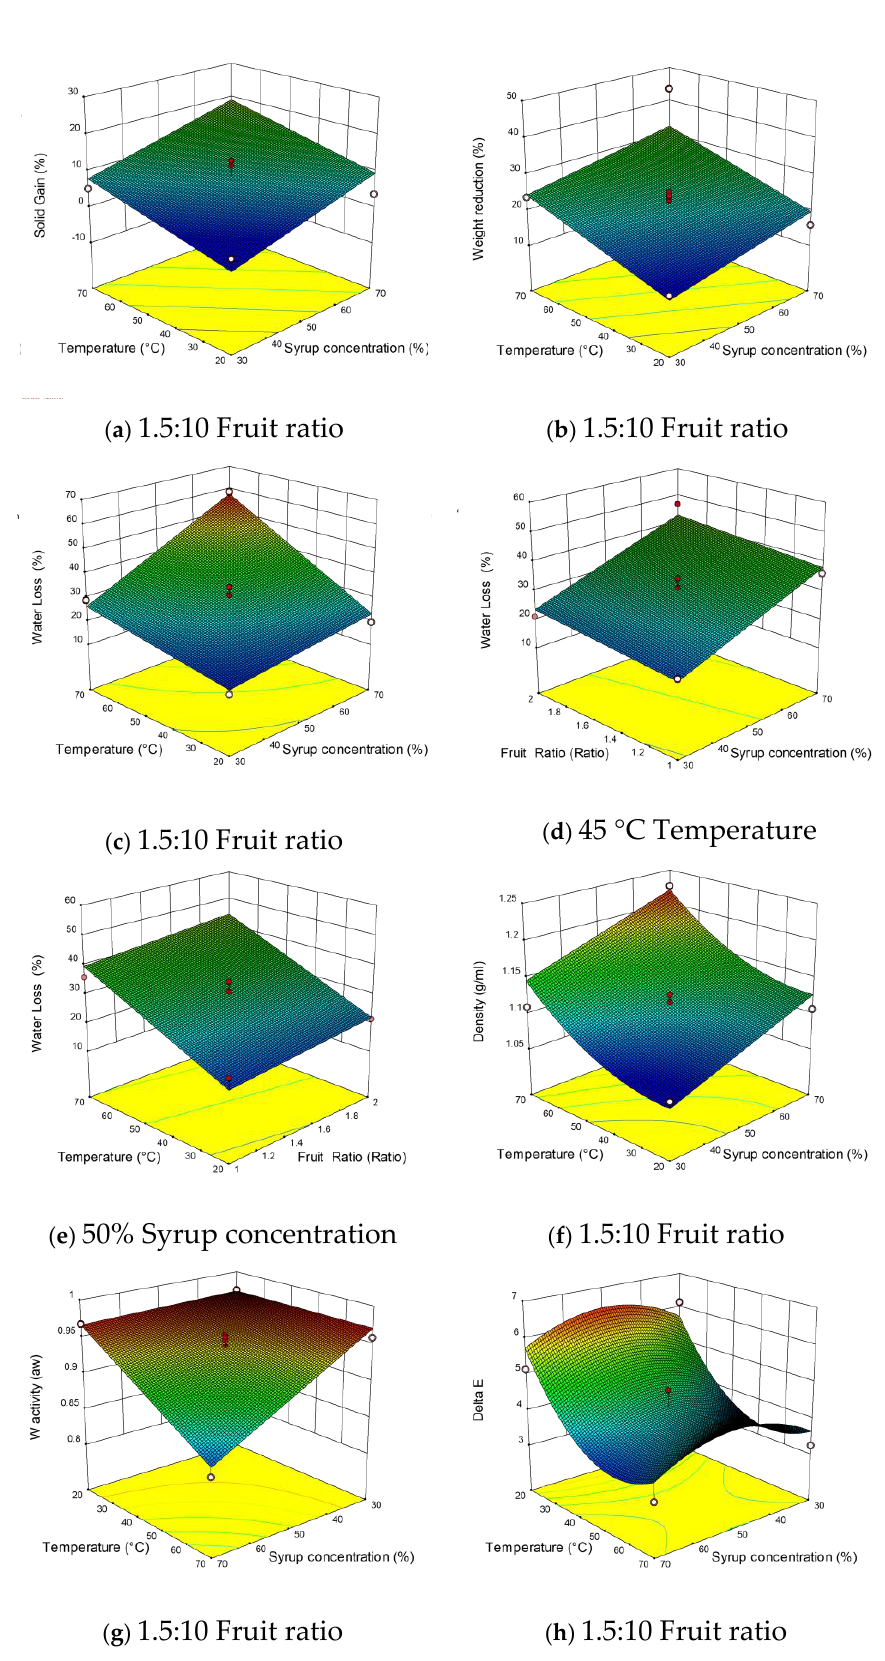
Figure 1. Response surface plots for different mass transfer parameters SG ( a ), WR ( b ), WL ( c – e ), ρ ( f ), a w ( g ), ΔE ( h ) during the osmotic dehydration of autumn olive berries.